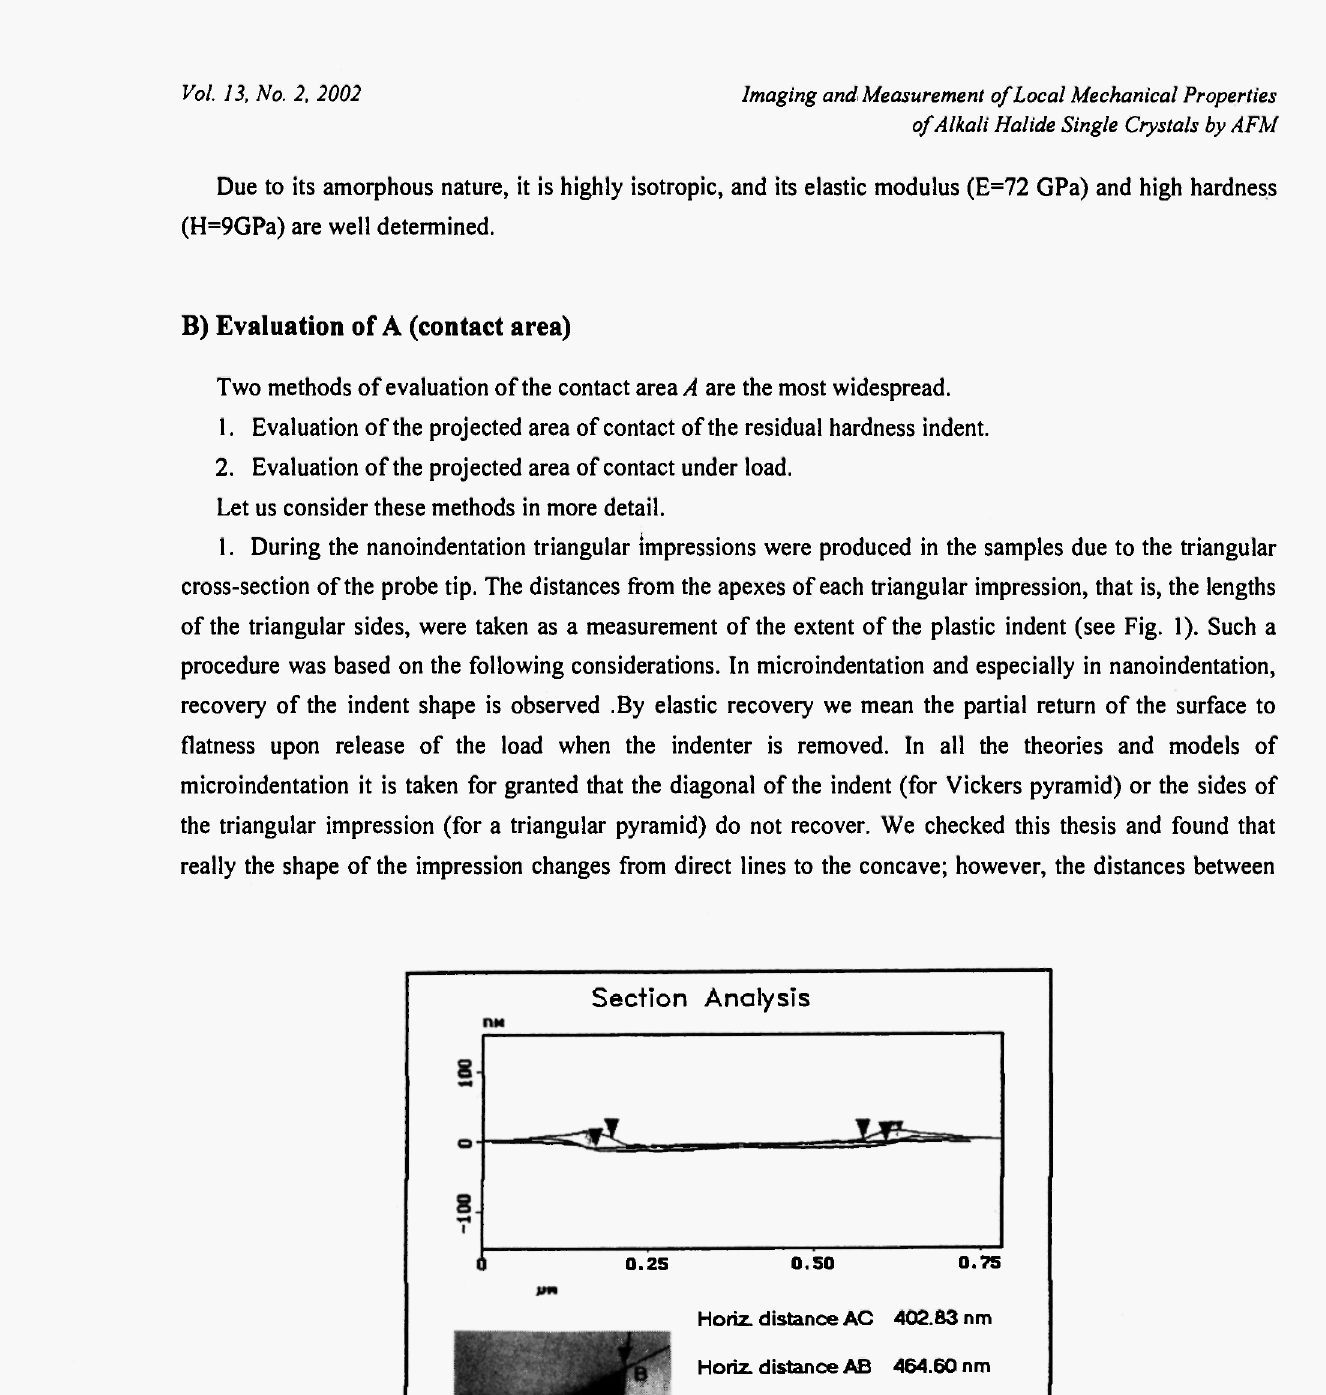
Fig. 1: Measurement of the contact area. The arrows indicate distances between the apexes of the triangle